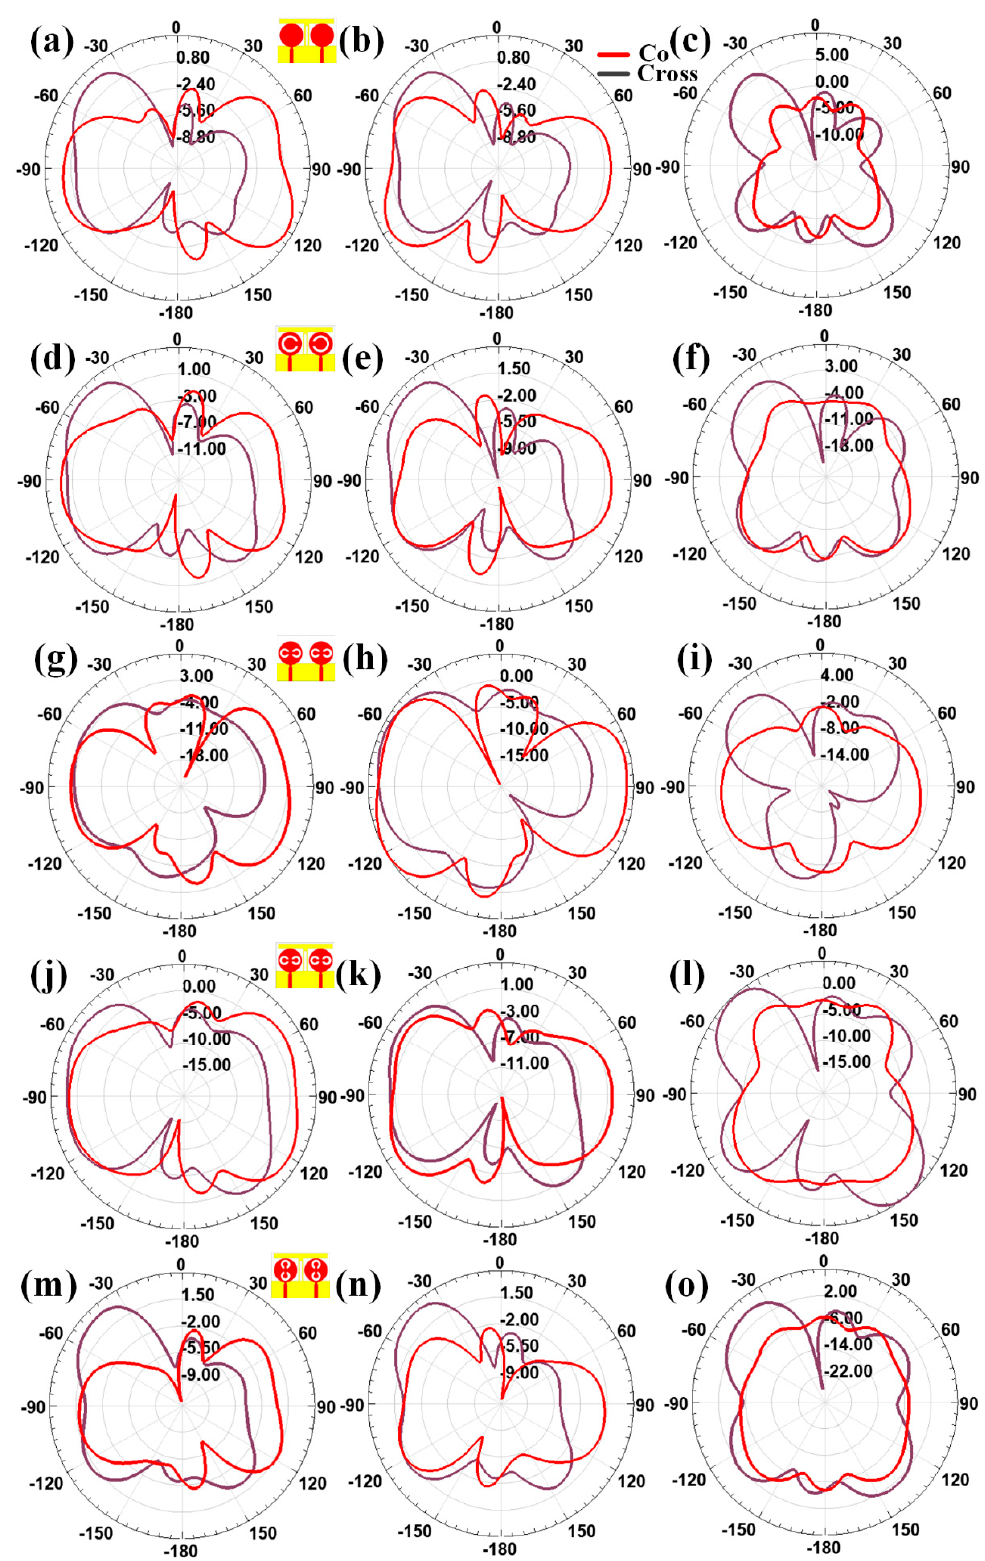
Figure 5. Variation in the radiation in 2D polar plots for the different port excitation conditions of ( a – c ) design 1, ( d – f ) design 2, ( g – i ) design 3, ( j – l ) design 4, and ( m – o ) design 5 antenna. The different port excitation conditions are ( a , d , g , j , m ) P 1 = 0 and P 2 = 1, ( b , e , h , k , n ) P 1 = 1 and P 2 = 0, and ( c , f , i , l , o ) P 1 = 1 and P 2 = 1.